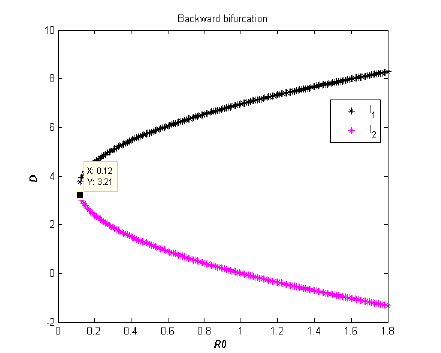
Figure 2. Bifurcation diagram for dengue infected individuals with